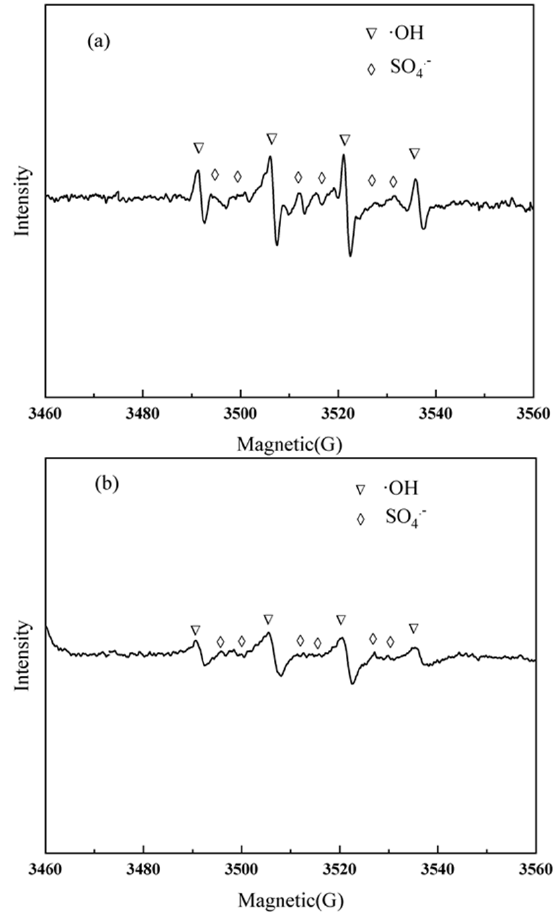
Figure 3. Free radical quenching experiment: ( a ) Na 2 SO 4 free; ( b ) [Na 2 SO 4 ] = 3 g/L; ( c ) contribution of reactive substances to the overall degradation efficiency. Reaction conditions: [PS] = 40 mg/L, Fe 2+ /PS = 0.3, pH = 7, [TBA] 0 = 0.5 mM, and [EtOH] 0 = 0.5 mM. Figure 4. EPR absorption spectra of ferrous/PS system: ( a ) Na 2 SO 4 free; ( b ) [Na 2 SO 4 ] 0 = 3 g/L, [PS] 0 = 40 mg/L, Fe 2+ /PS = 0.3, and pH = 7.